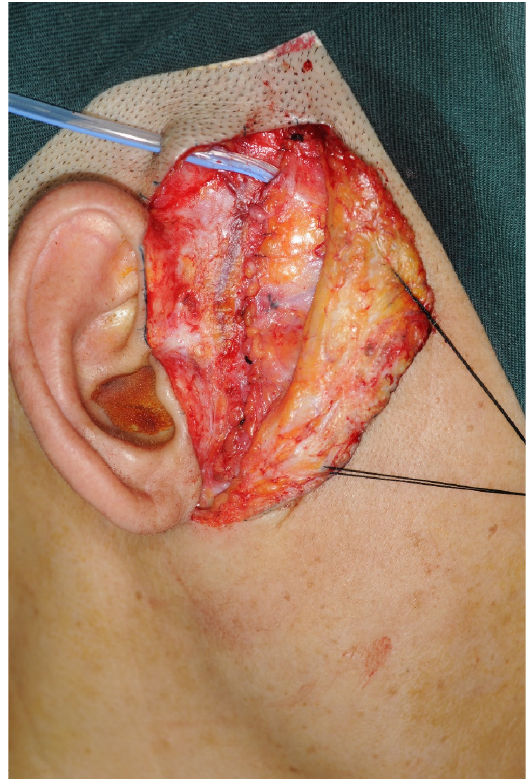
Figure 3. A 100 mL negative pressure drainage tube was placed under the deep temporal fascia.